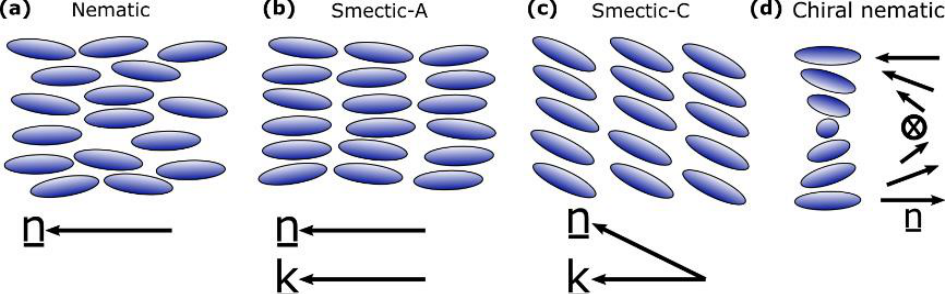
Figure 3. Schematics of ( a ) the nematic phase, ( b ) the smectic-A and ( c ) smectic-C phases in which the director, ( n ) is parallel to and at specific angle to the layer normal ( k ), respectively, ( d ) the chiral nematic phase which has a characteristic pitch [8]. The black arrows indicate the director in each case.